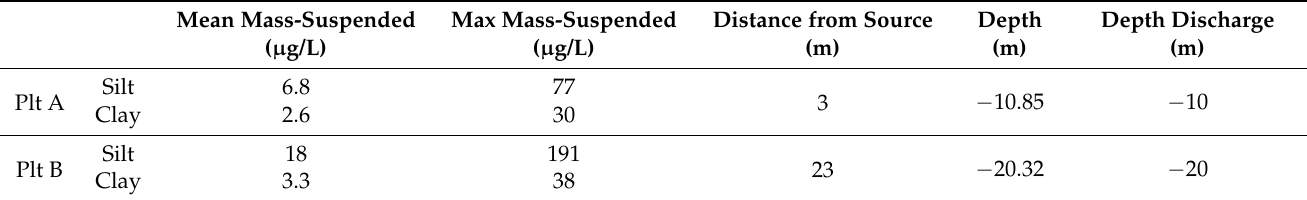
Figure 13. Map (WGS 84 UTM 33N) of monthly mean concentration of clay suspended as result by MIKE 3 PT module output for ( a ) Plt A at 10 m depth and ( b ) Plt B at 20 m depth. Table 7. TSS values for platform A and B during one-month simulation detected at the point of max concentration.